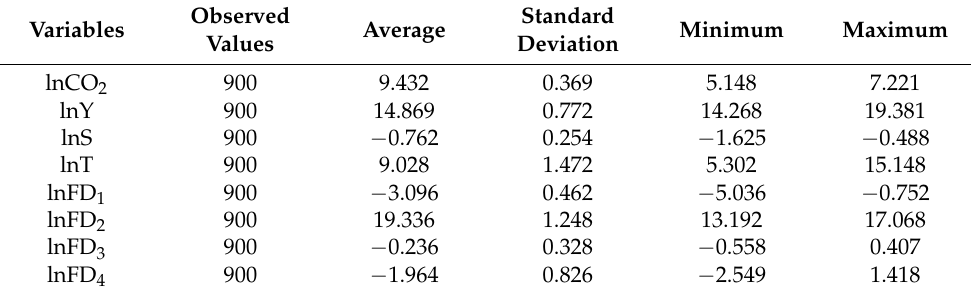
Table 4. Descriptive